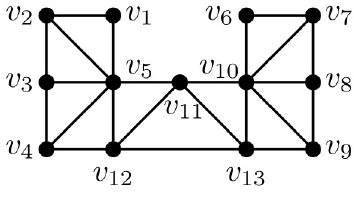
Figure 4. A 2-tree H